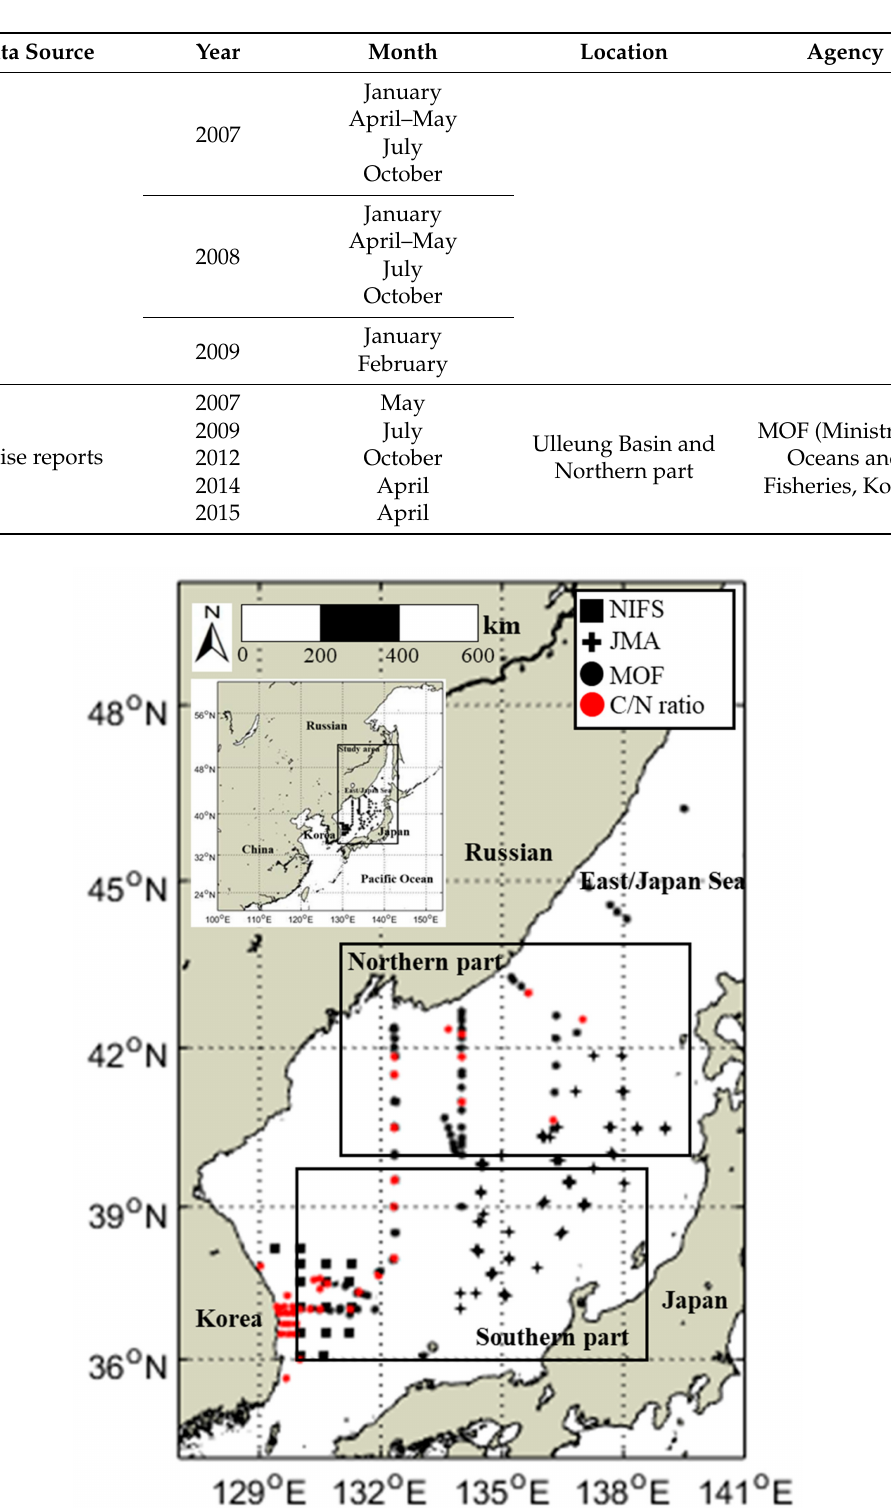
Figure 1. Field measurement stations in the East/Japan Sea (EJS). Squared dots indicate the NIFS (National Institute of Fisheries Sciences, Korea) stations. Cross marks are the JMA (Japan Meteorological Agency, Japan) stations. Dots are the MOF (Ministry of Oceans and Fisheries, Korea) stations. Red dots are the locations of C/N ratio measured